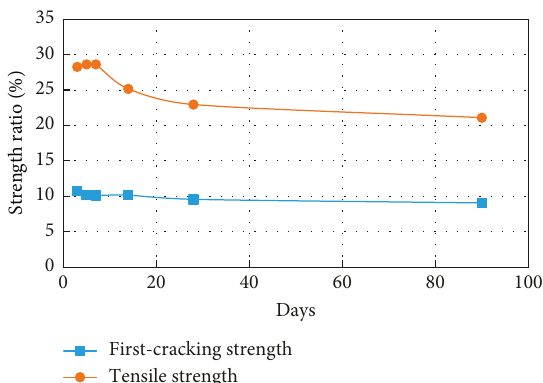
Figure 4: Ratio of the first-cracking strength and the tensile strength to the compressive strength with time.